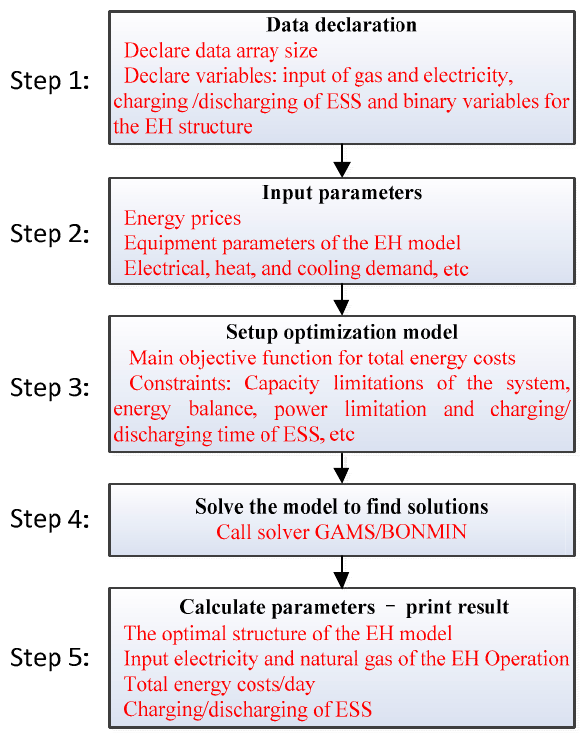
Figure 9. The process of solving the problem using GAMS. ESS: energy storage system; GAMS: General Algebraic Modeling System.